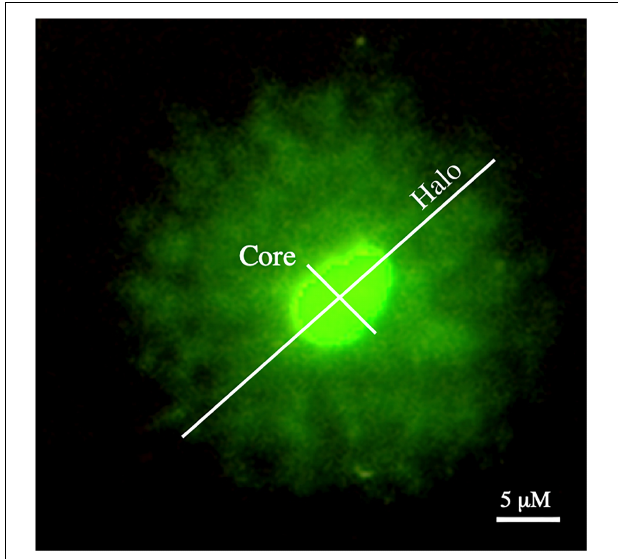
FIGURE 1 | Measurement of core and halo in sperm cells with decondensed